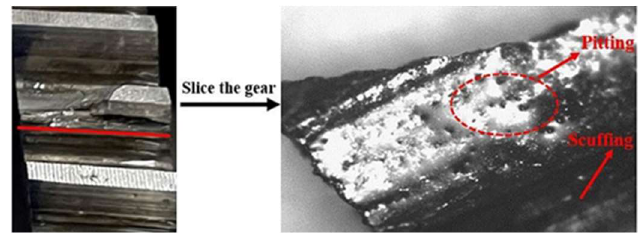
Figure 13. Failure gear of the end.